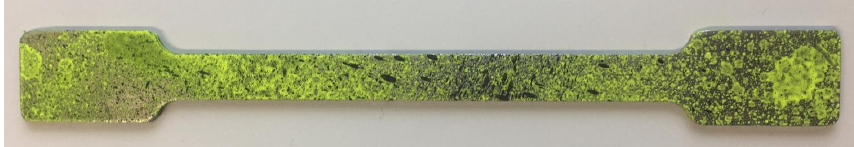
Figure 3. Painted specimen with random pattern for the calculation of